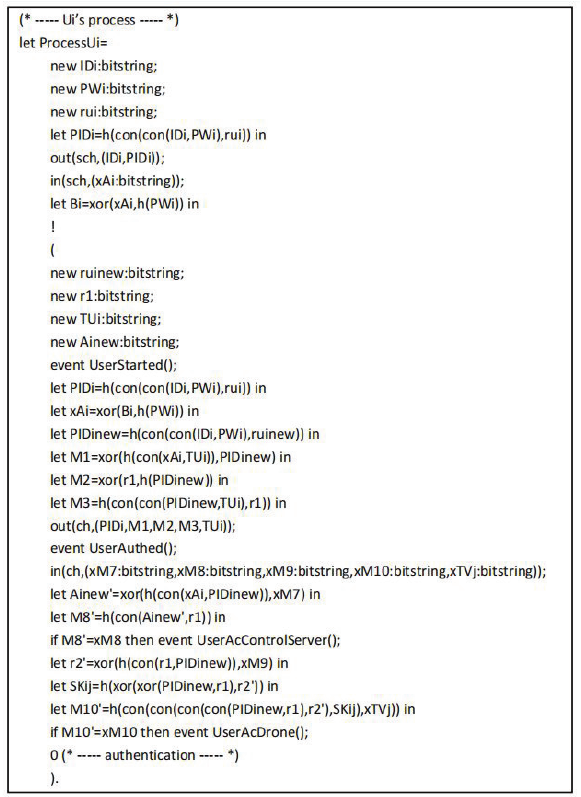
Figure 7. The process of U i